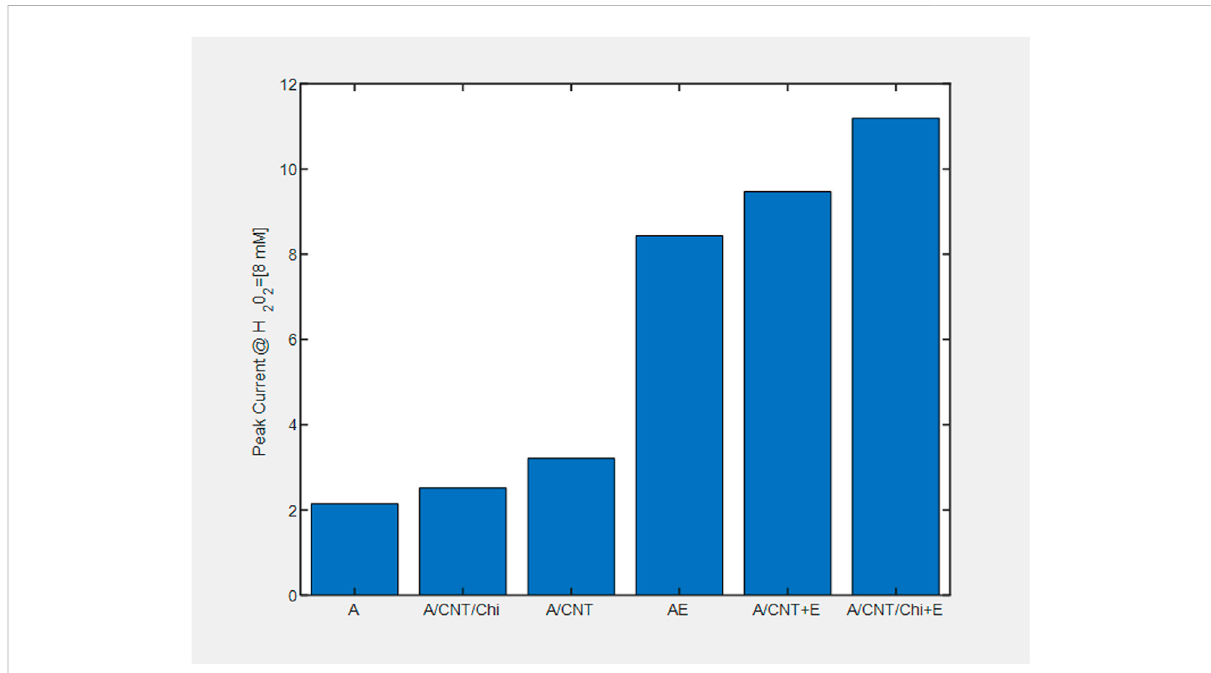
FIGURE 9 Peak current at − 0.4 V relative to the background signal from the voltammograms of nanocomposite biosensing fi lms for 2 μ l of H 2 O 2 (8